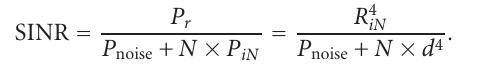
From Figure 1(a), when N = 1 and R i 1 = d × 4 area between R s and R i 1 can be defined as the first layer of the hidden node area, within which a single interfering